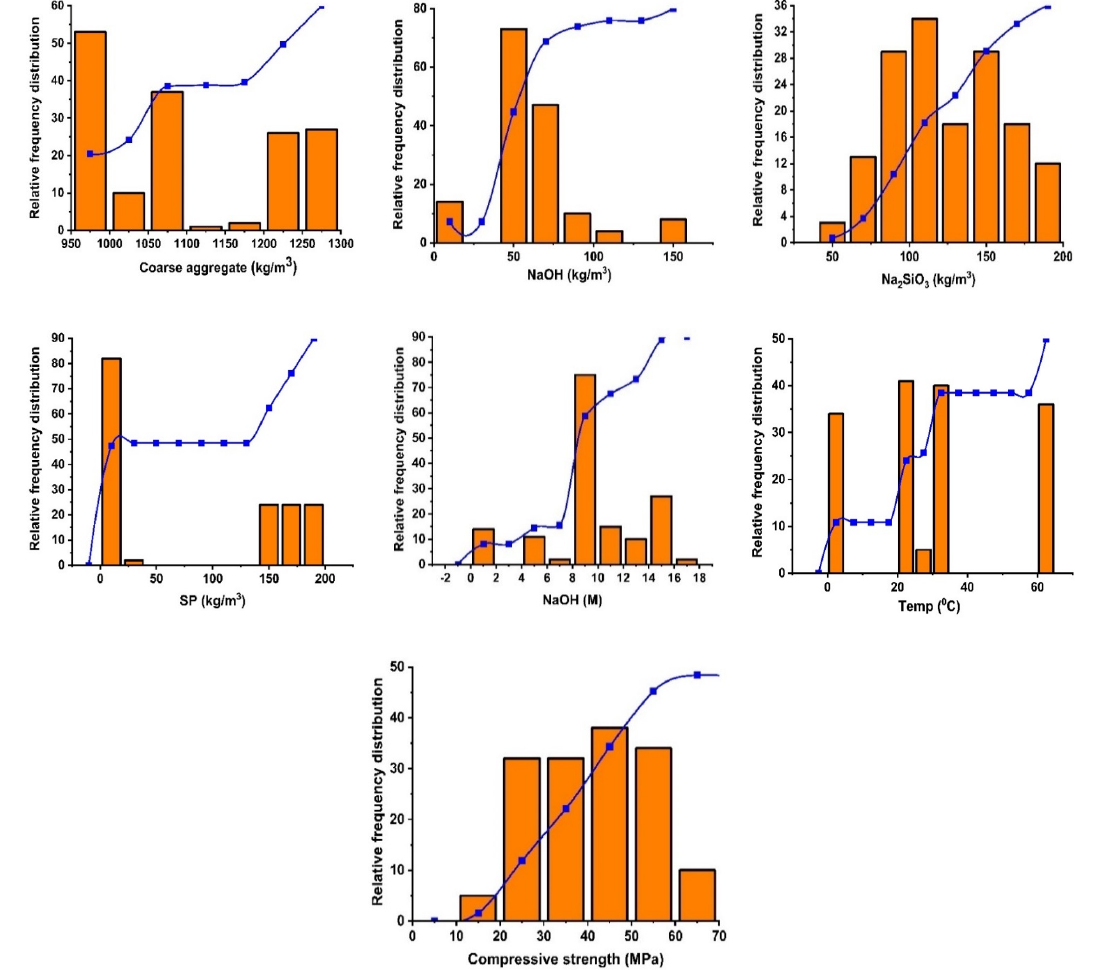
Figure 1. Frequency distribution of input and output parameters. Table 2. Contribution of parameters with ranges. Table 3. Descriptive data of